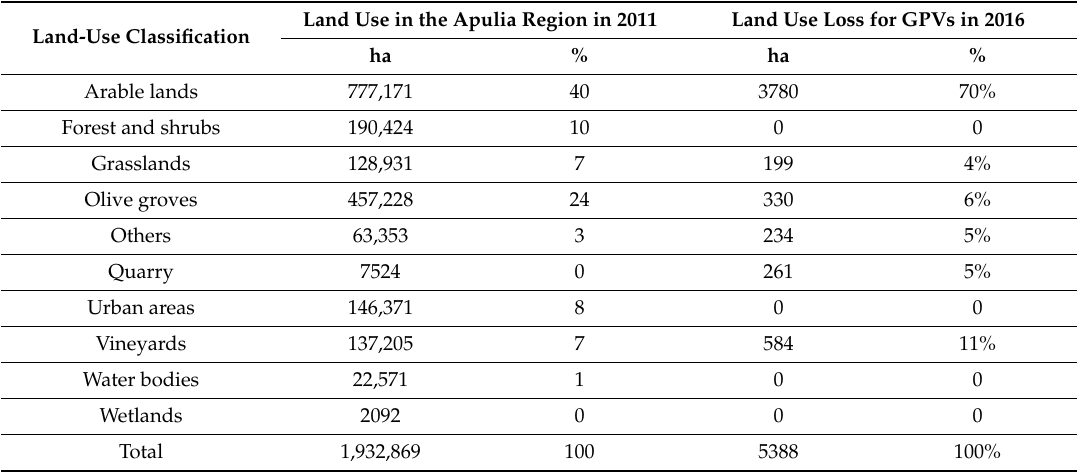
Table 1. The main land use of the Apulia region and loss of land use caused by the realisation of ground photovoltaic (GPV) systems.